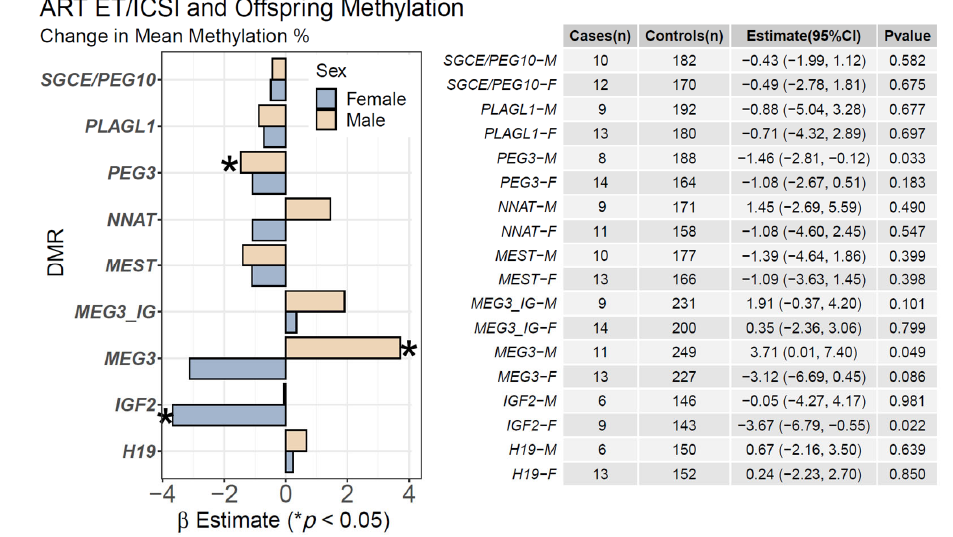
Figure 2. Associations of ART ET/ICSI and Mean CpG Methylation: We assessed the relationship between ART use for the index pregnancy and mean CpG methylation at nine DMRs using linear regression. We stratified models by sex and adjusted for pyrosequencing batch, pre-pregnancy maternal BMI, race, maternal age, diabetes, and parity. Estimates ( β ) are shown for males (tan) and females (blue) and represent the mean percentage of methylation change associated with maternal use of ART (* p < 0.05).